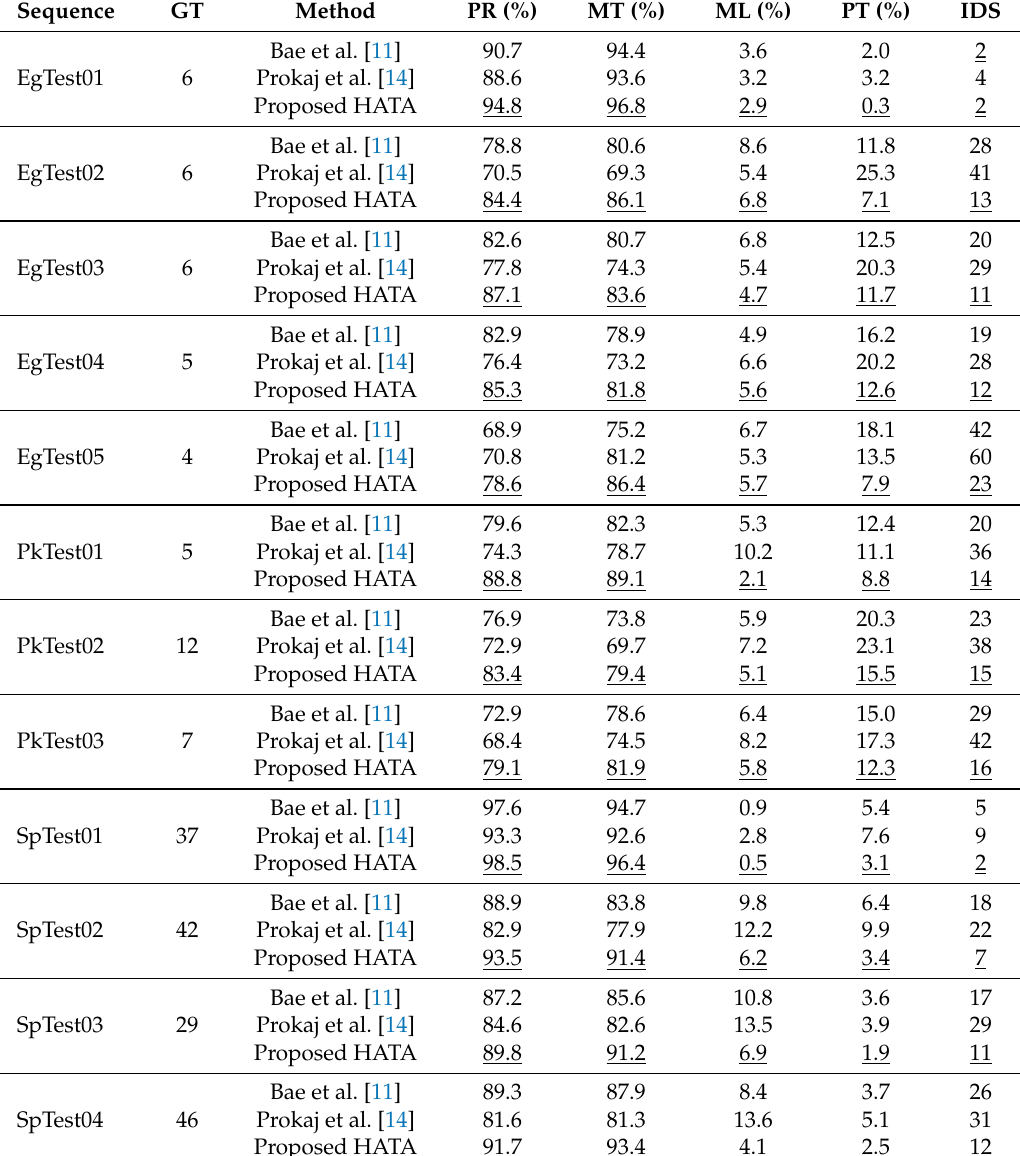
Table 5. Tracking results on the selected datasets. The best results are